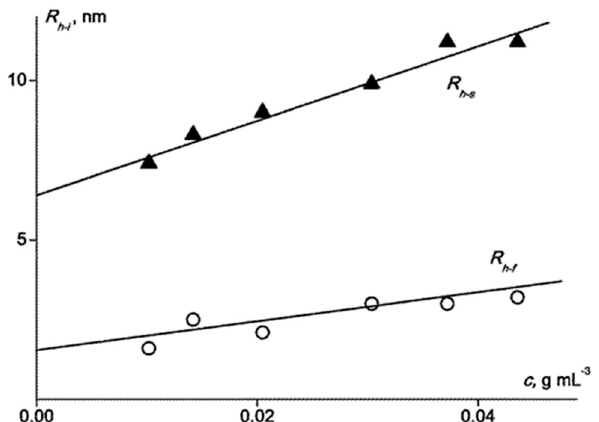
Figure 3. The concentration dependence of hydrodynamic radii of fast R f and slow R s modes of CL-PiPrOx in 2-NP.